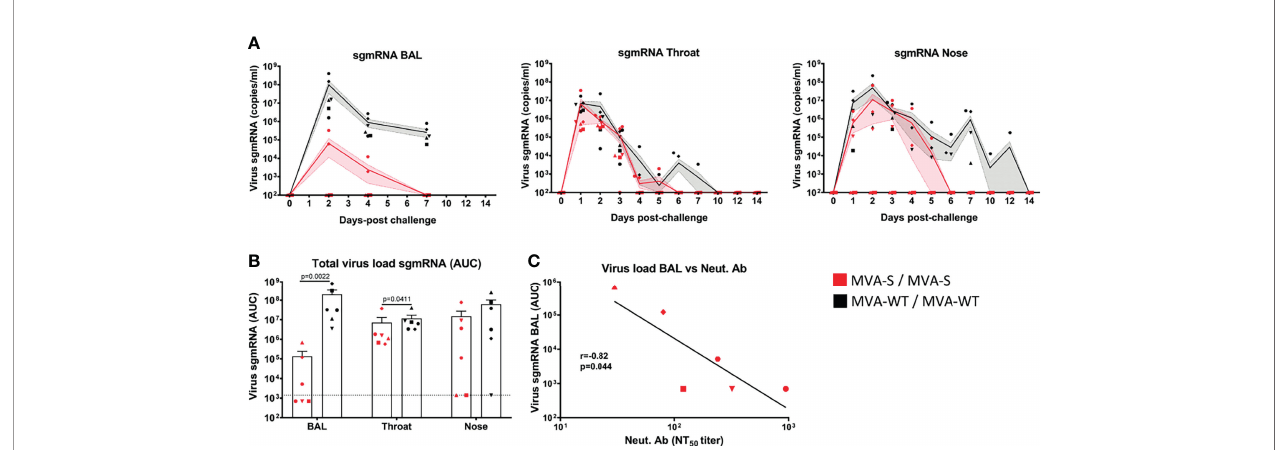
FIGURE 5 | Control of SARS-CoV-2 replication by MVA-S vaccine candidate. (A) SARS-CoV-2 sgmRNA load (copies/ml) in lung (BAL), throat, and nose of MVA-S (red) and MVA-WT (black) immunized macaques (symbols) at different days post-challenge. Averages and SEM per group are indicated by lines with shaded areas. (B) Total SARS-CoV-2 sgmRNA load in BAL, throat and nose of MVA-S (red) and MVA-WT (black) immunized animals over time, as measured by the area under the curve (AUC). Individual animals (symbols), averages, and SEM are shown in columns and bars for each group of animals. Signi fi cant differences between the groups are indicated in the graph by a horizontal line and p-value (Mann – Whitney test). (C) Correlation between total sgmRNA SARS-CoV-2 load in BAL and neutralizing antibody titers measured at week 6 against the SARS-CoV-2 MAD6 strain (having the D614G mutation in the S protein) in animals immunized with MVA-S. The correlation was calculated by Pearson correlation test on log-transformed data. The black line represents interpolated data, as a linear